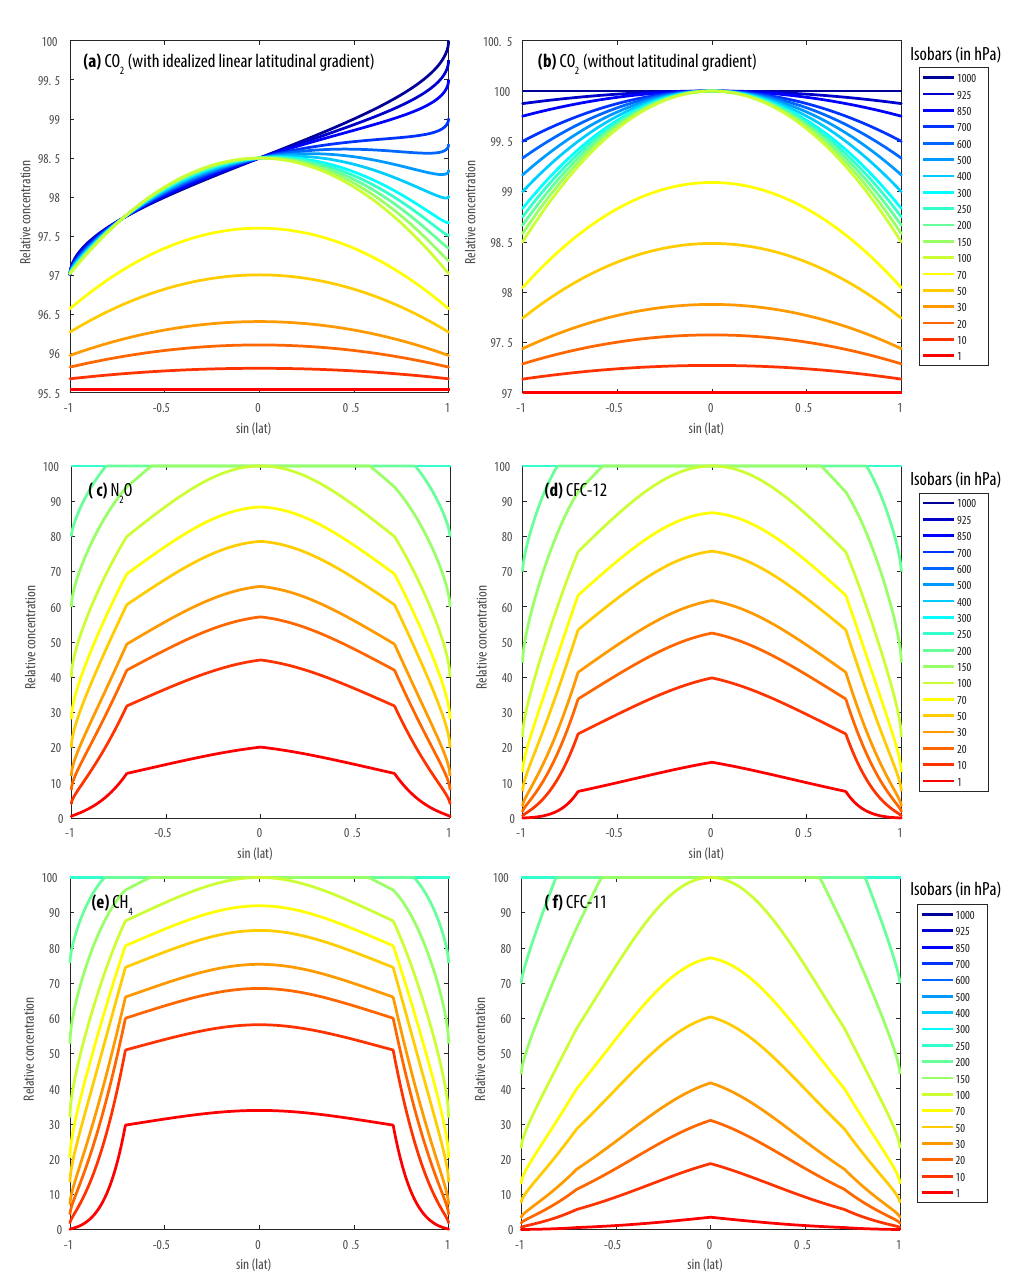
Figure 14. Idealized vertical gradients recommended for implementation of surface concentration fields. For parametric formulas, see text. Note that tropospheric columns of non-CO 2 gases are – for simplicity – assumed to be well-mixed. The assumed age of air at the 1hPa level for CO 2 is 5